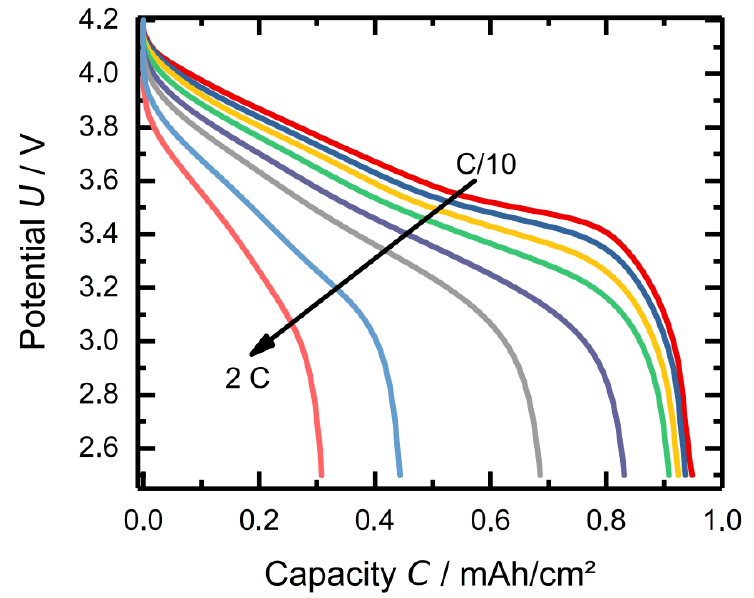
Figure 3. C-rate performance of a graphite/NCM cell with 1 M LiTFSI in TBAC:EC:EMC:DEC (60:15:5:20 wt) electrolyte at T = 25 ◦ C in the potential range of 2.5–4.2 V. The applied currents were: C /10, C /5, C /3, C /2, 0.75 C , 1 C , 1.5 C , and 2 C . At a current